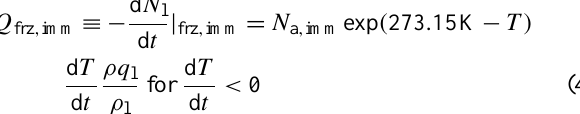
Table 2. The modal structure of HAM with its aerosol species: sulphate (SO 4 ), black carbon (BC), organic carbon (OC), sea salt (SS), mineral dust (DU) and bacteria (BCT). The radius range of the aerosol particles in the respective mode is given by r . Modes Size range [µm] mixed/soluble insoluble Nucleation r ≤ 0 . 005 SO 4 Aitken 0.005 < r ≤ 0 . 05 SO 4 , BC, OC BC, OC Accumulation 0.05 < r ≤ 0 . 5 SO 4 , BC, OC, SS, DU DU Coarse 0.5 < r ≤ 1 SO 4 , BC, OC, SS, DU DU Bioaerosol 1 <